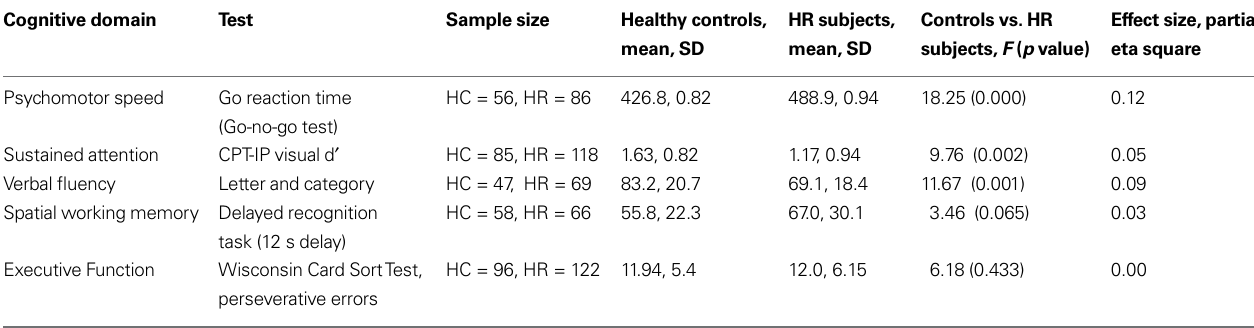
Table 2 | Neurocognitive fi ndings in young relatives of schizophrenia patients in the Pittsburgh High-Risk Study. Cognitive domain